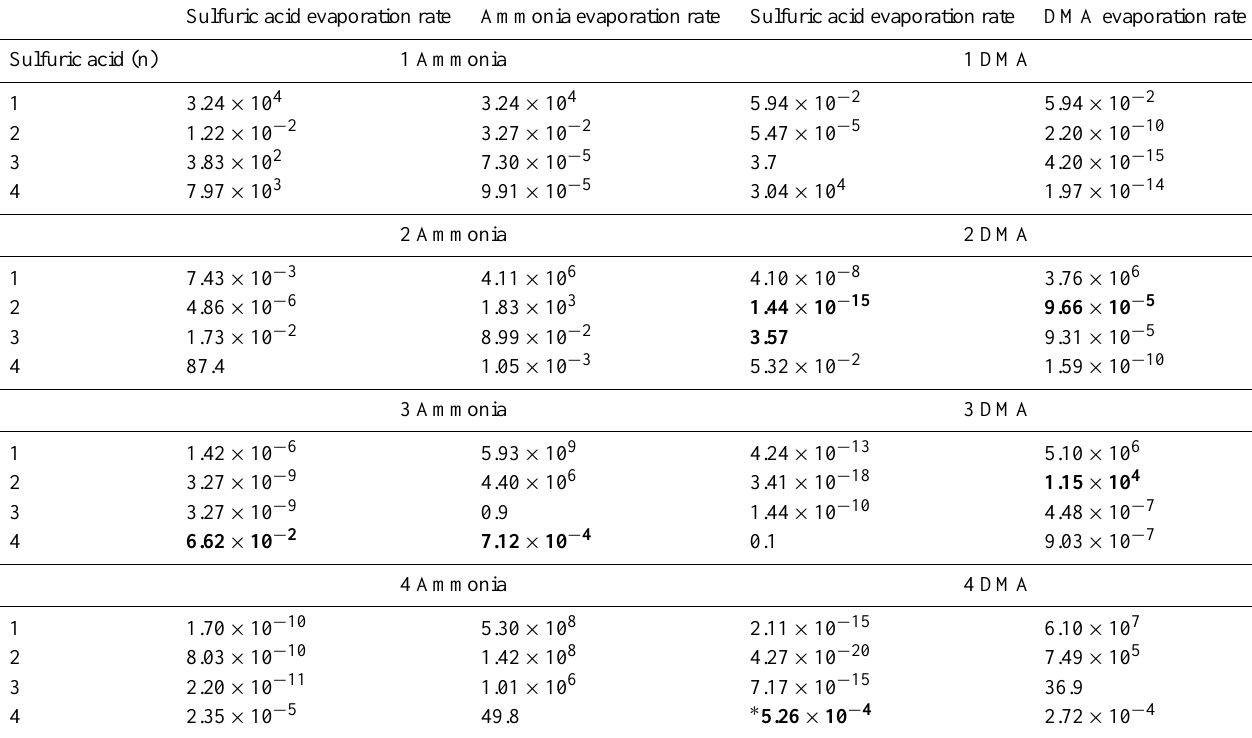
Table 5. Evaporation rates (1s − 1 ) for different clusters included in this work. ( ∗ typographic error